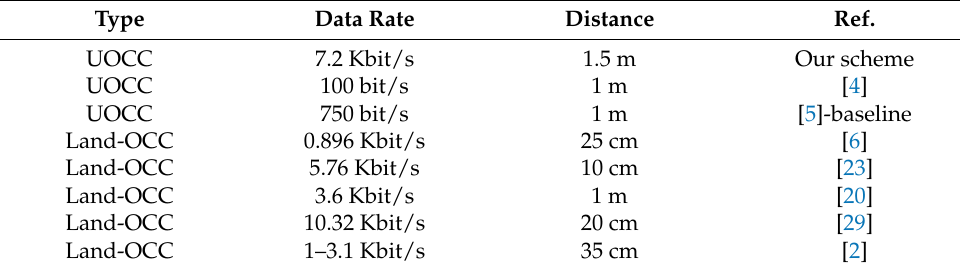
Table 4. Comparison between different